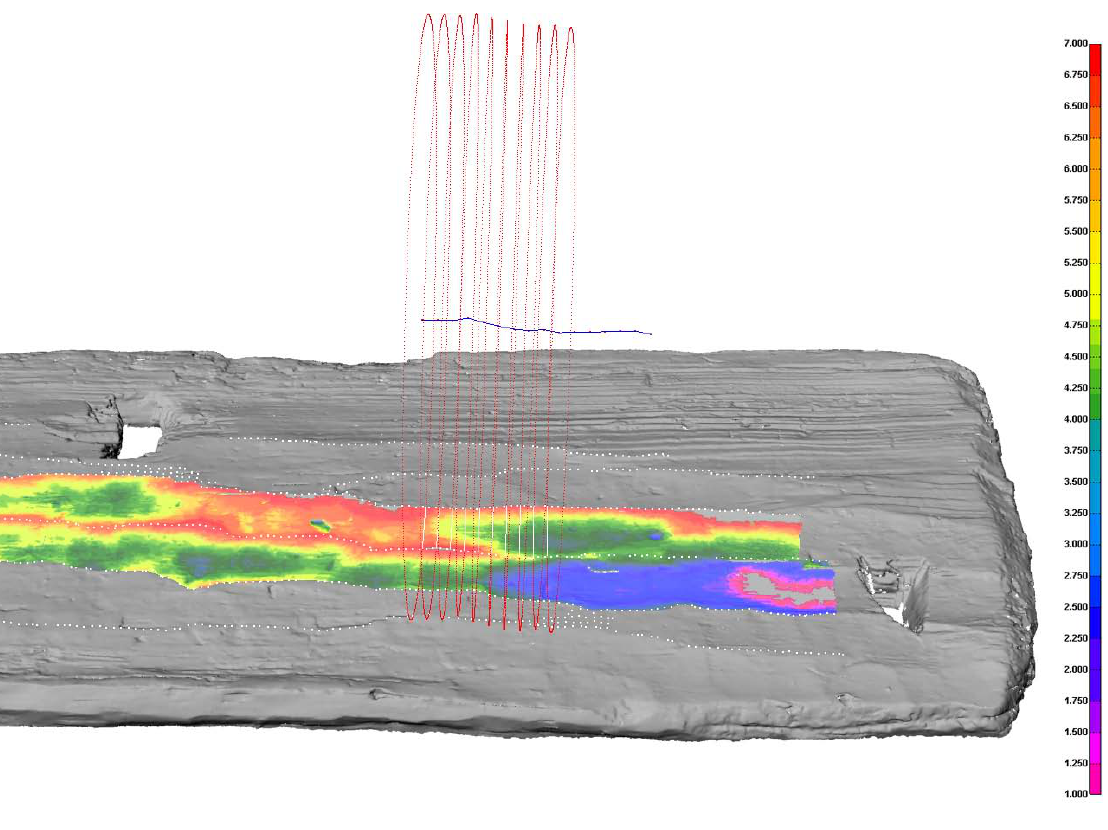
Figure 4. The comparison between sliding tool marks and horizontal reference plane (in mm) is visualised together with the results of hydrologic and feature-based surface